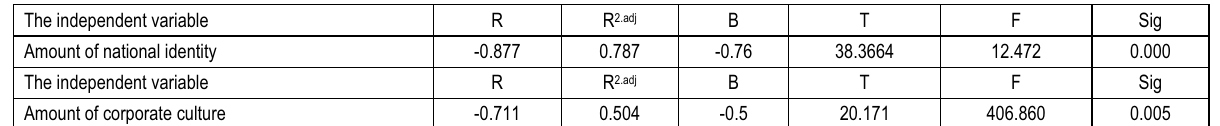
Table 1. Results of regression correlation coefficient between national identity/organizational culture and tendency to administrative